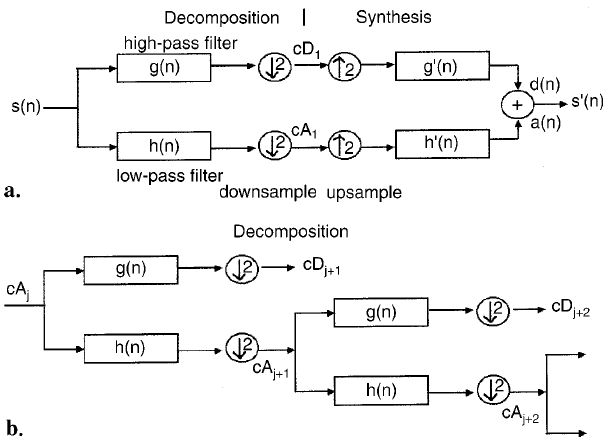
Fig. 10a, b. Pyramid scheme (or the Mallat algorithm) of the MRA. a Decomposition and synthesis of the signal ( s ( n )); g and h ( g ¢ and h ¢ ) are the analysis (synthesis) FIR filters, cD respectively the detail and approximation coe(cid:129)cients at level 1. b Decomposition of the signal ( s ( n )) from level j to j